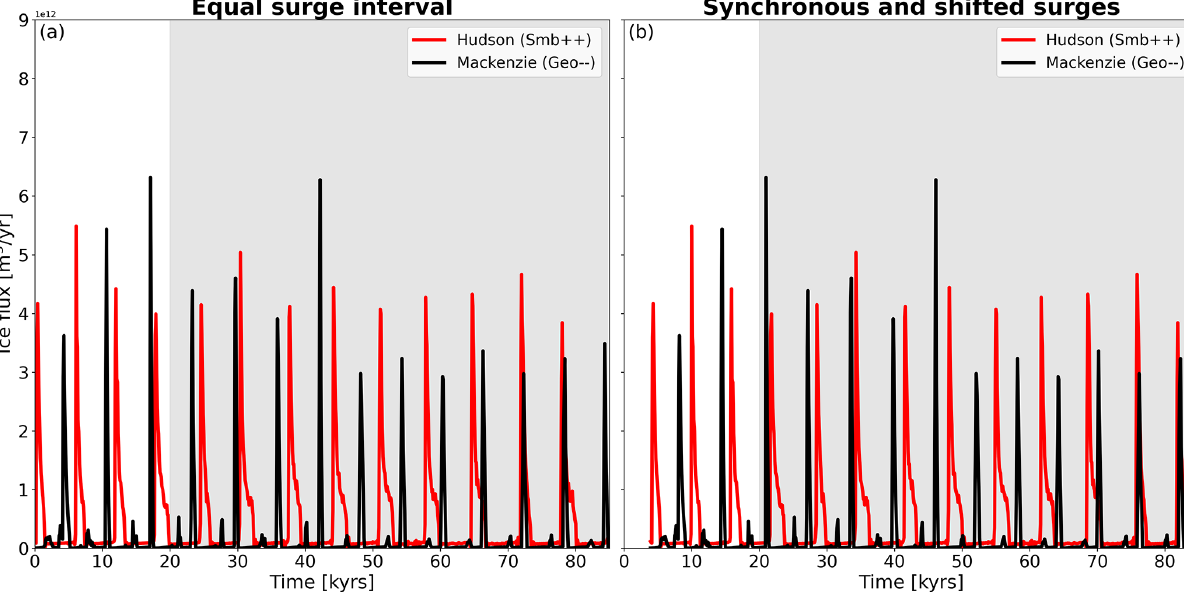
Figure 12. Time series of the ice flux through the flux gate (Fig. 1) for Hudson and Mackenzie ice stream showing (a) an equal surge interval and (b) synchronous